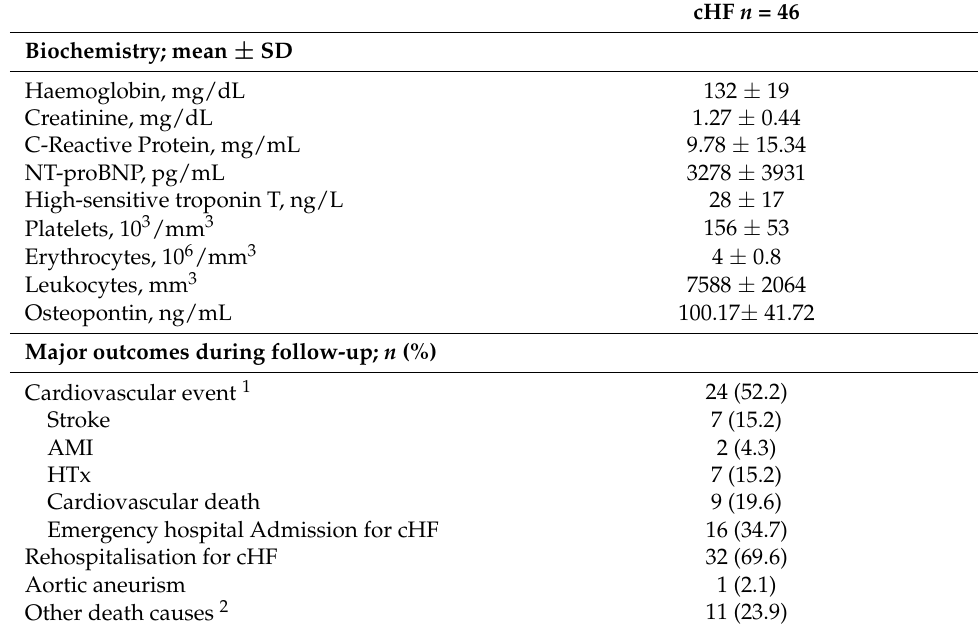
Table 7. Biochemical and clinical outcomes of cHF patients in the miRNA